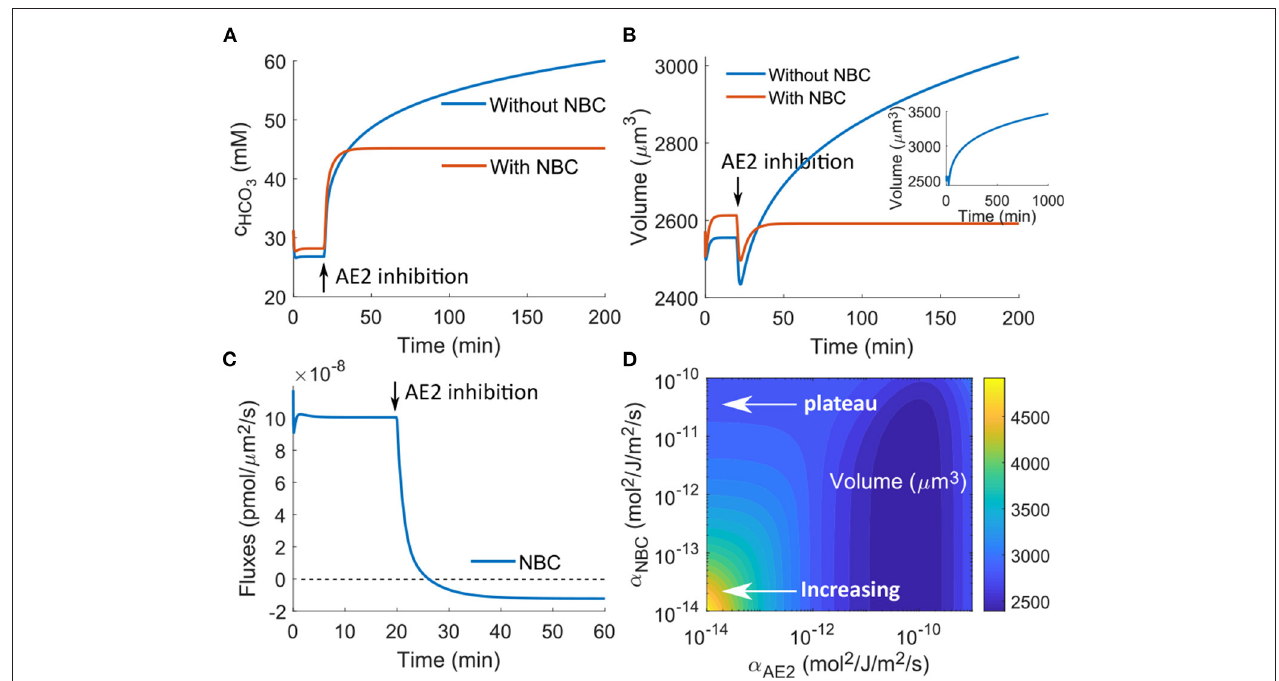
FIGURE 6 | Model predictions of the cellular response upon AE2 inhibition applied at t 0 = 20 min by reducing α AE2 by three orders of magnitude. (A) Intracellular HCO − 3 concentration change with and without NBC. (B) Model prediction of the cell volume with and without NBC. The insert is a longer time response without NBE, which shows continuous increasing volume in time. (C) NBC flux upon AE2 inhibition. (D) Contour plot of the cell volume as a function of the permeability coefficients of NBC and